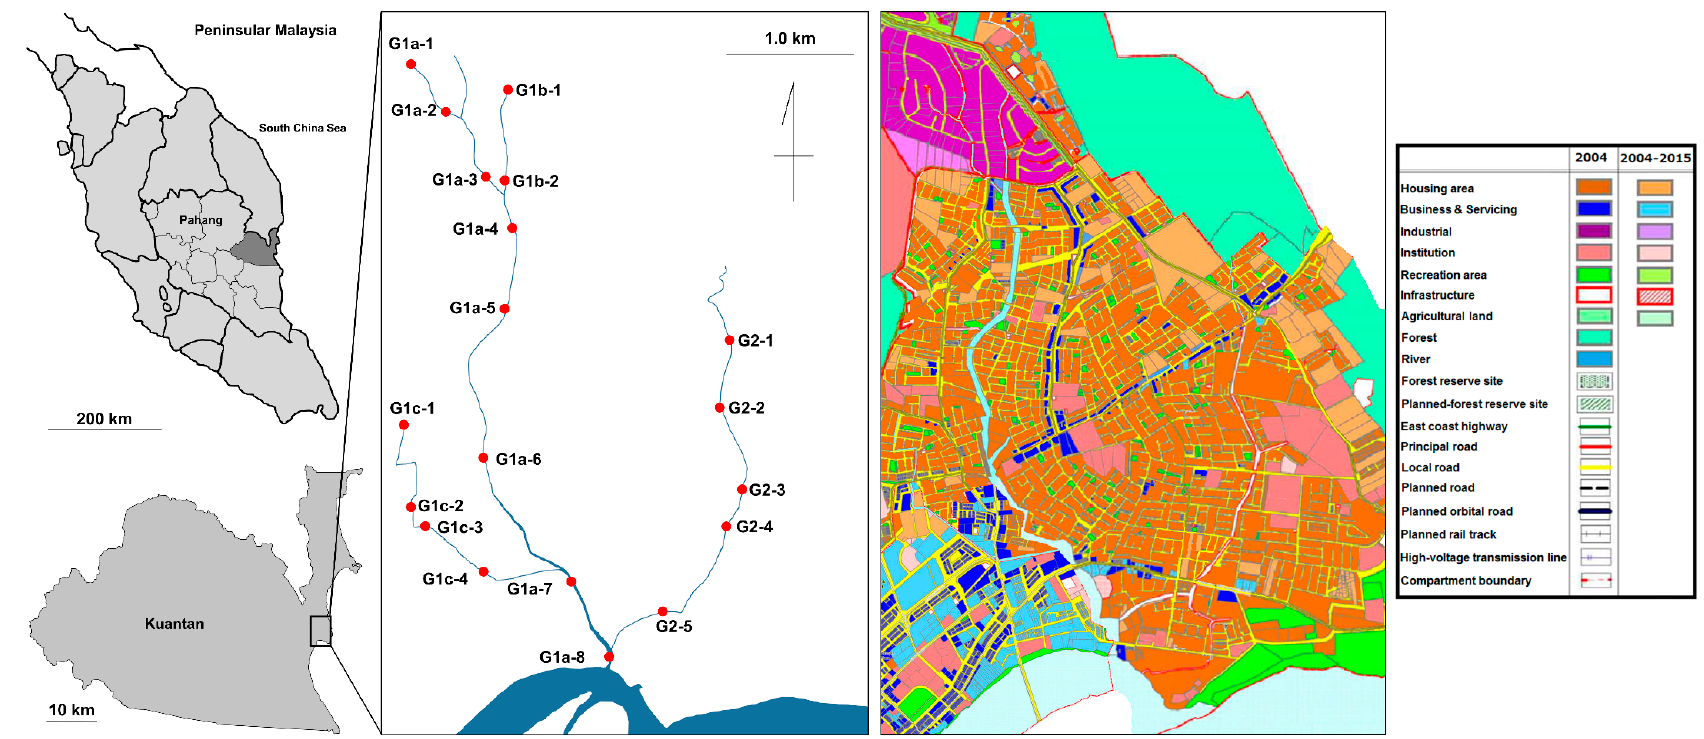
Figure 1. Map of sampling locations and land use pattern in Kuantan city. Note: This figure was constructed based on the data obtained from the Pahang Town and Country Planning Department (JPBD: Jabatan Perancangan Bandar Dan Desa) Pahang Town and Country Planning Department [7].